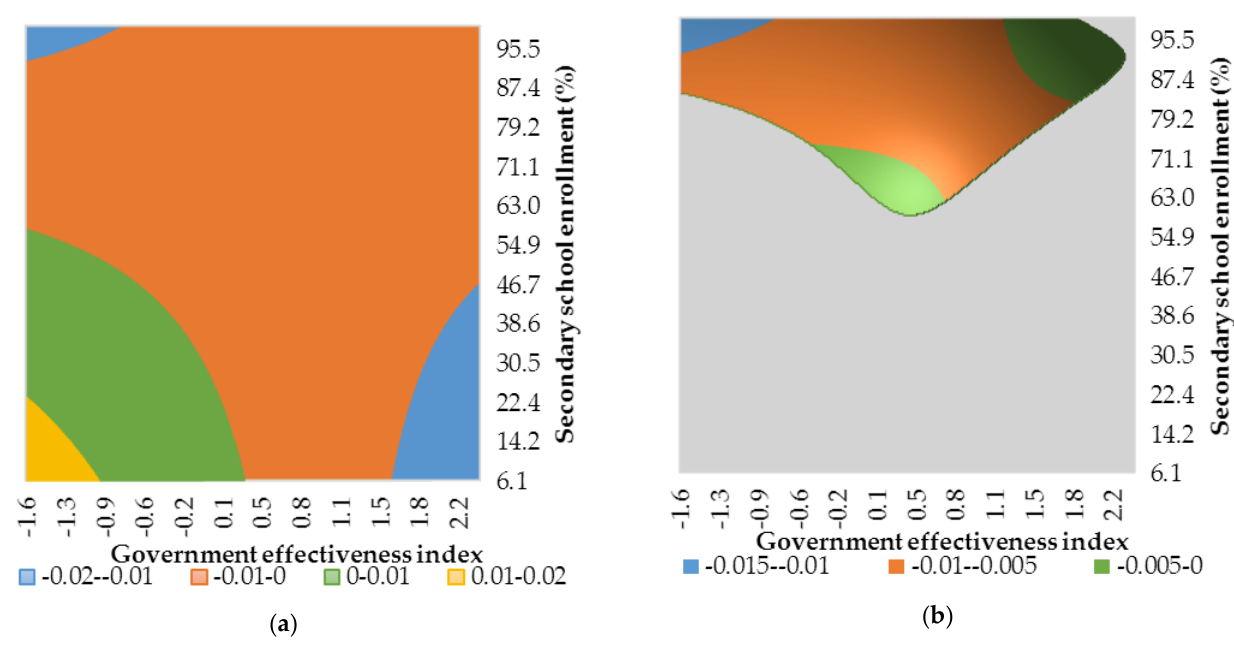
Figure A2. Conditional effect of financialisation on growth based on Est. 2 in Table A2. ( a ) Estimated conditional slope coefficient over the whole range of observed values for institutional quality and development level. ( b ) Estimated statistically significant conditional slope coefficient. Gray represents a combination of institutional quality and development level for which effect of financialisation on growth is statistically insignificant. Source: authors’ contributions.